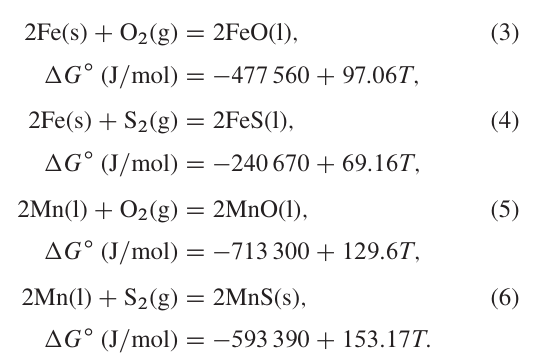
The amounts of Fe, Mn, Mg, Ca and P were an- alyzed using inductive coupled plasma-atomic emission spectroscopy (ICP-AES, Optima